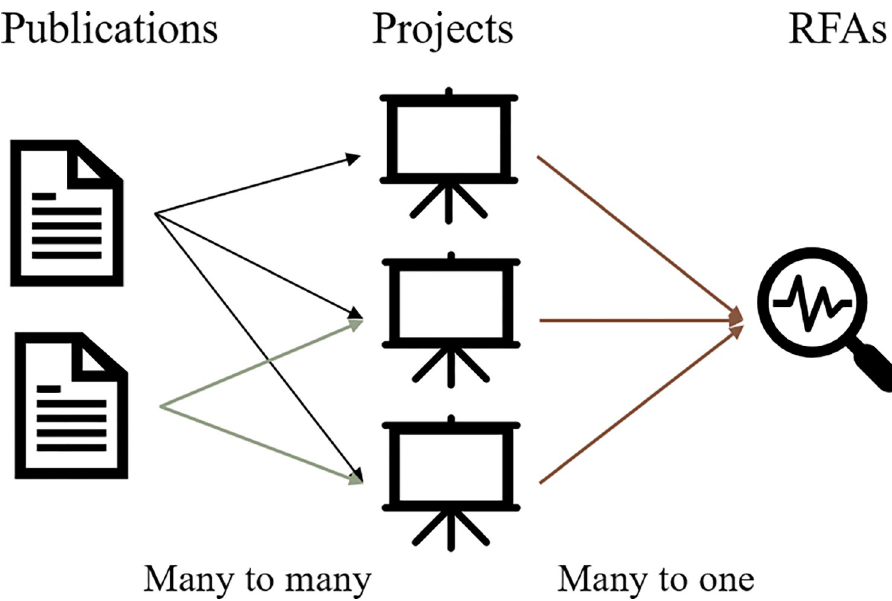
Fig 4. Relations between publications and RFAs through project